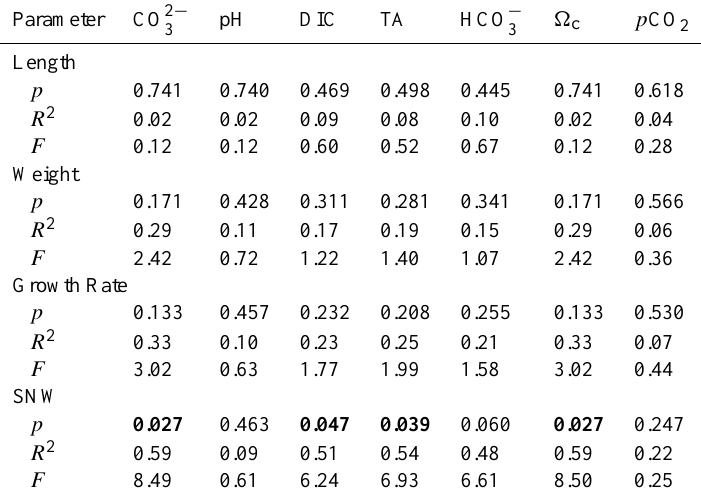
Table 2. Results of linear regression model between SNW and individual carbonate system parameters (based on averages of the eight treatments). Statistically significant regressions (at p < 0 . 05) are displayed in